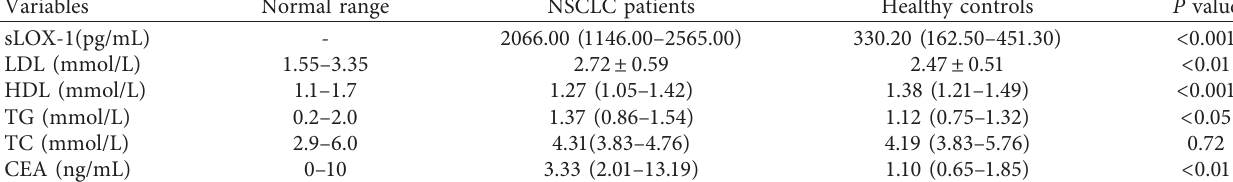
Table 2: The expression levels of sLOX-1, blood lipid metabolism indexes, and CEA in the serum of two groups of patients.